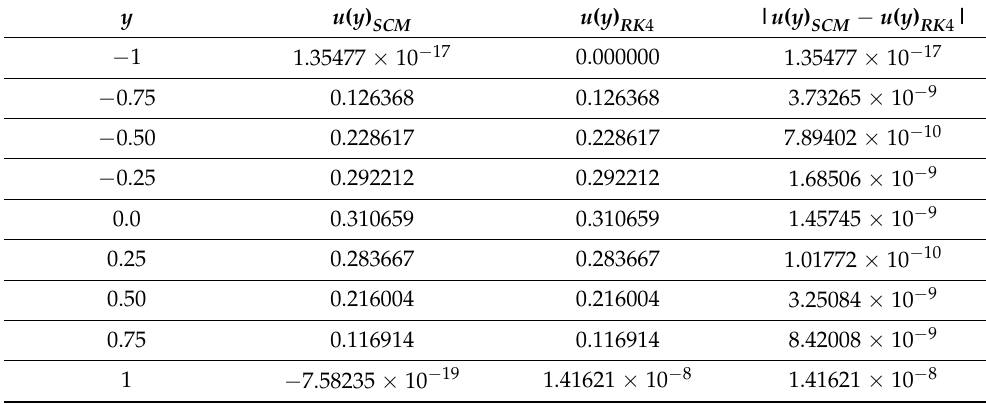
Table 2. Validation of result of Equation (12) when δ = β = γ = H = 1, λ = ε = α = 0.1